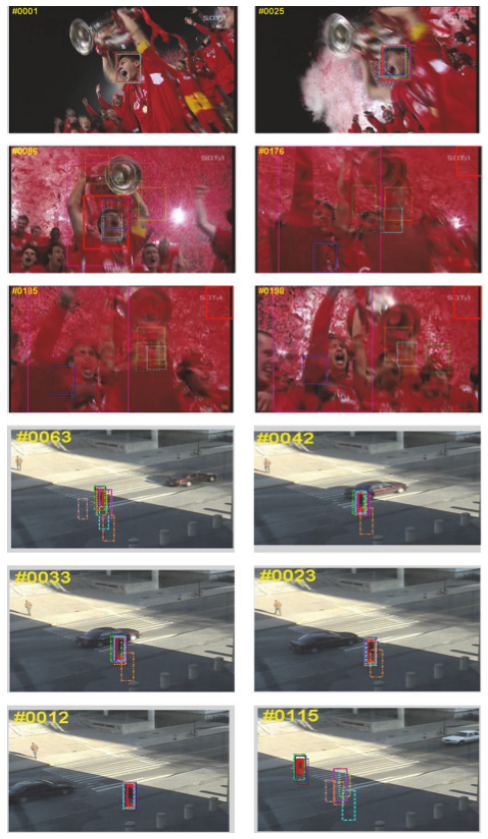
Figure 3: Examples of tracking results on representative frames of two sequences.